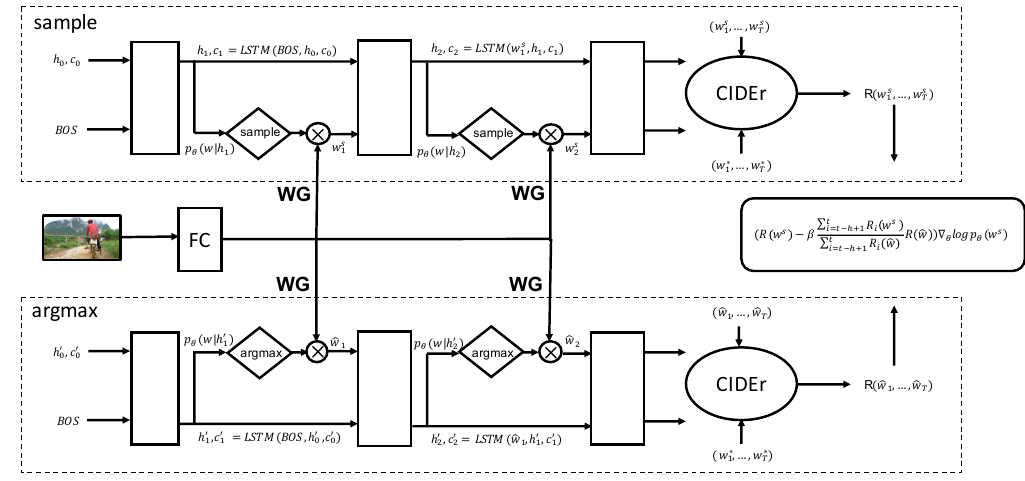
Figure 2. Overview of the word gate (WG) model and the adaptive self-critical sequence training (ASCST) method. The adaptive SCST contains two components: the sample component and the argmax component. The sample component is regarded as the policy network of the reinforcement learning (RL) method. The inference component is the baseline method to make the training more